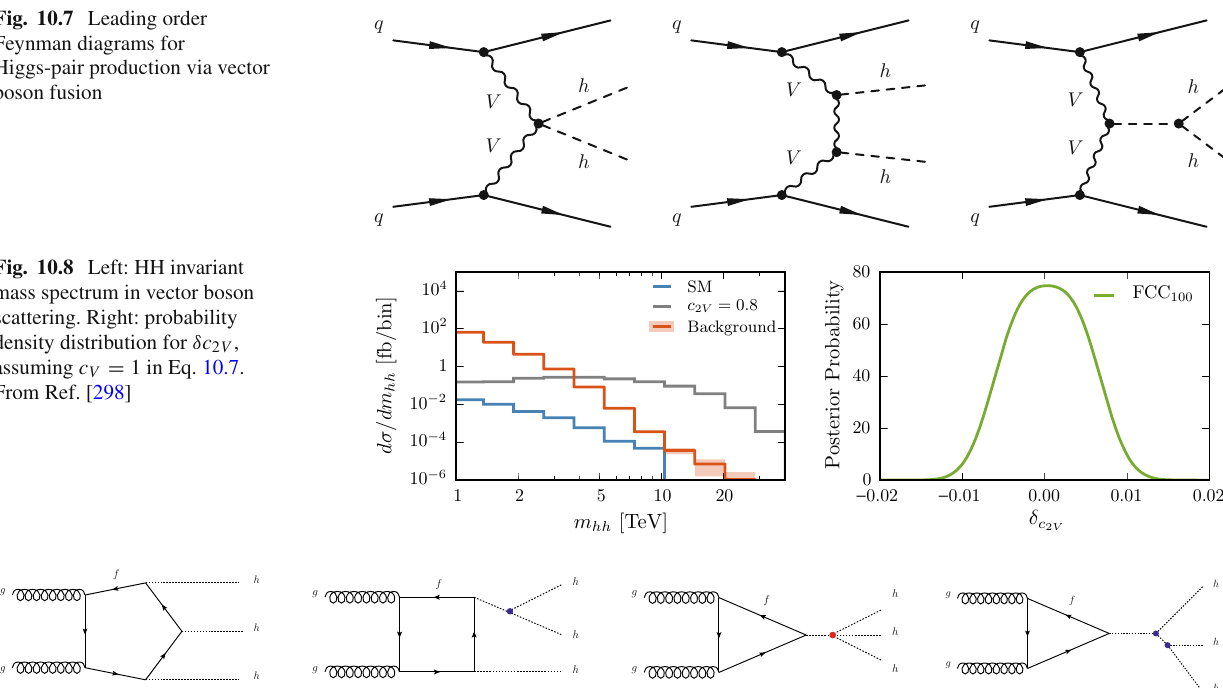
Fig. 10.9 Example Feynman diagrams contributing to Higgs boson triple production via gluon fusion in the Standard Model. The vertices highlighted with a blobs indicate either triple (blue) or quartic (red) self-coupling contributions